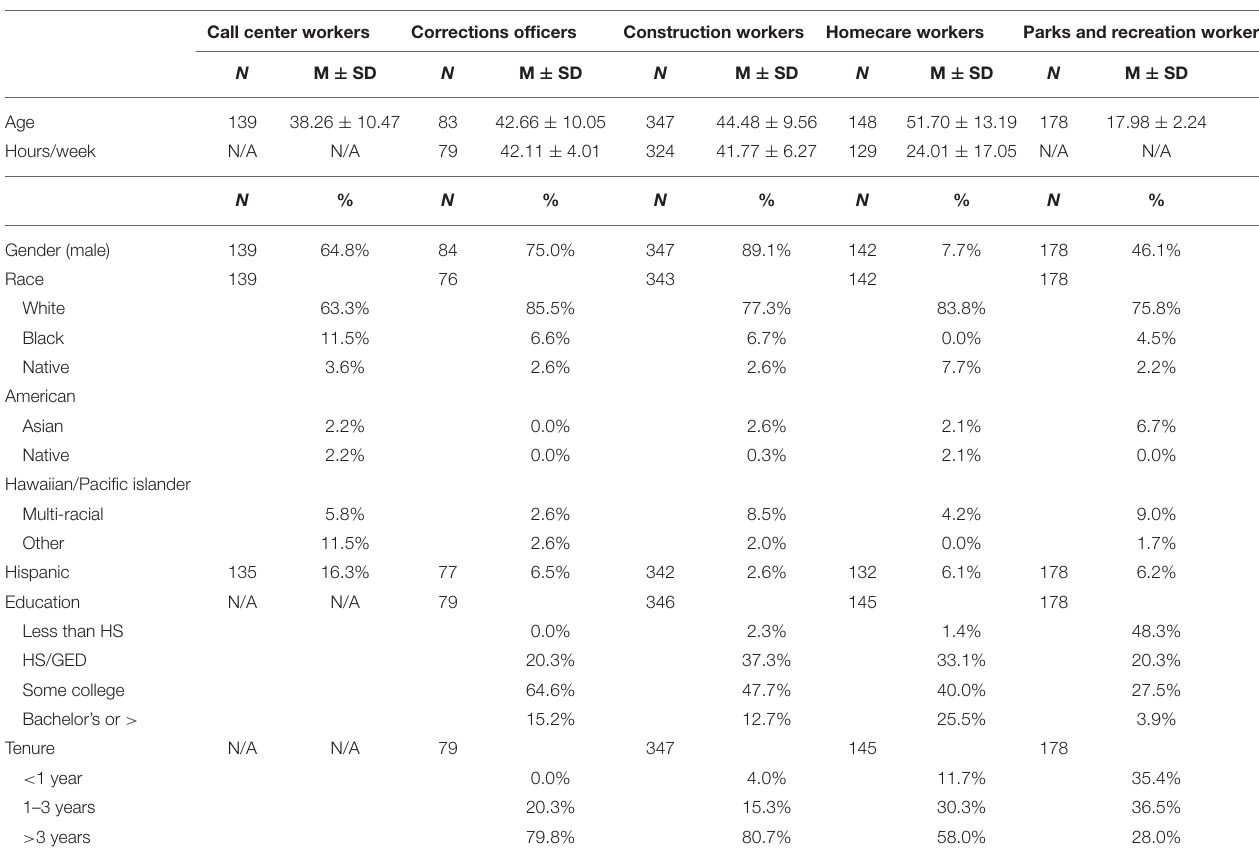
TABLE 1 | OHWC descriptive statistics, demographics, and work characteristics. Call center